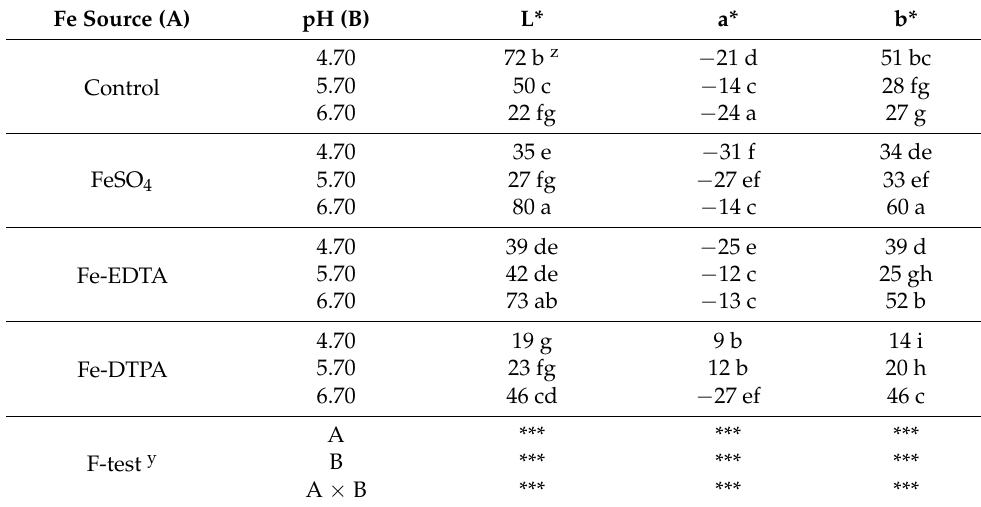
Table 2. The leaf color of S. commixta after 6 weeks of culture. Fe Source (A) pH (B) L* a* b* Control